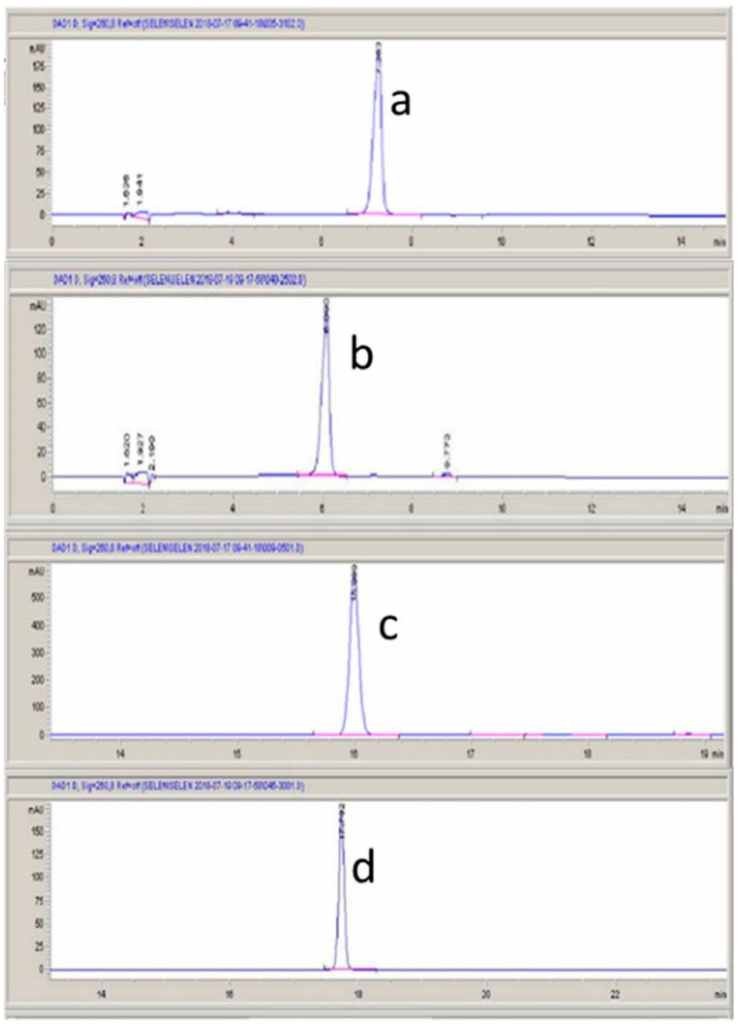
Figure 1. High-performance liquid chromatography (HPLC) chromatograms of the standards: